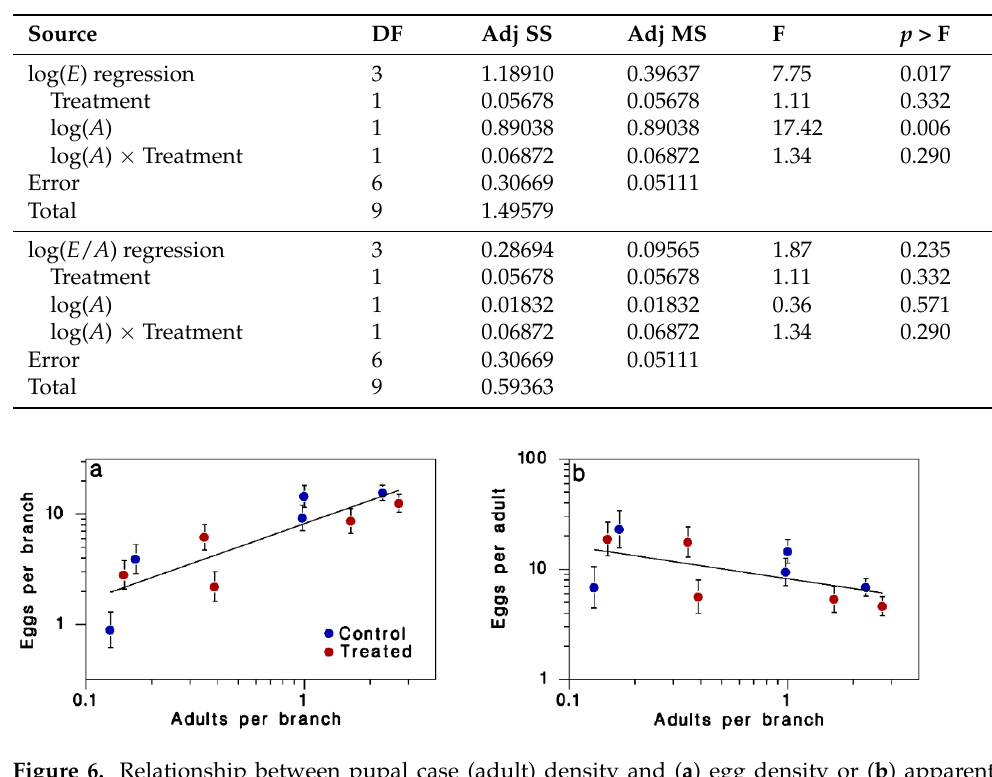
Figure 6. Relationship between pupal case (adult) density and ( a ) egg density or ( b ) apparent fecundity (eggs per adult). Means ± SEM; blue: control blocks; red: treated blocks. Line in ( a ) is Equation (1). Line in ( b ) has slope −0.299 ± 0.148, but this relationship did not reach significance (α = 0.05). Potential SBW fecundity is around 100 eggs/moth.